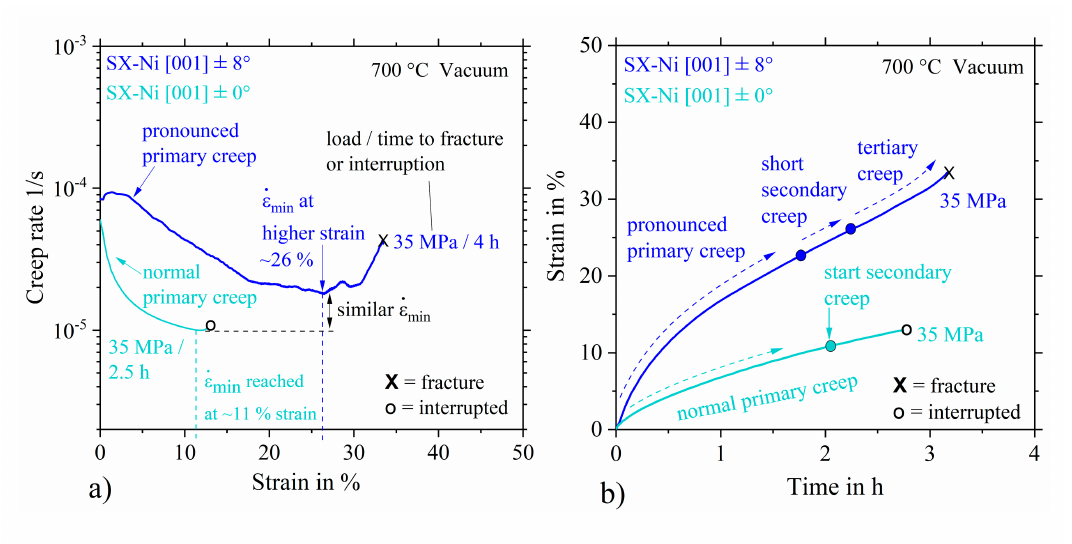
Figure 3. Influence of deviation from exact orientation [001] of pure Ni at 700 ◦ C, ( a ) creep rate over strain (extracted from Figure 2b), and ( b ) strain over time.